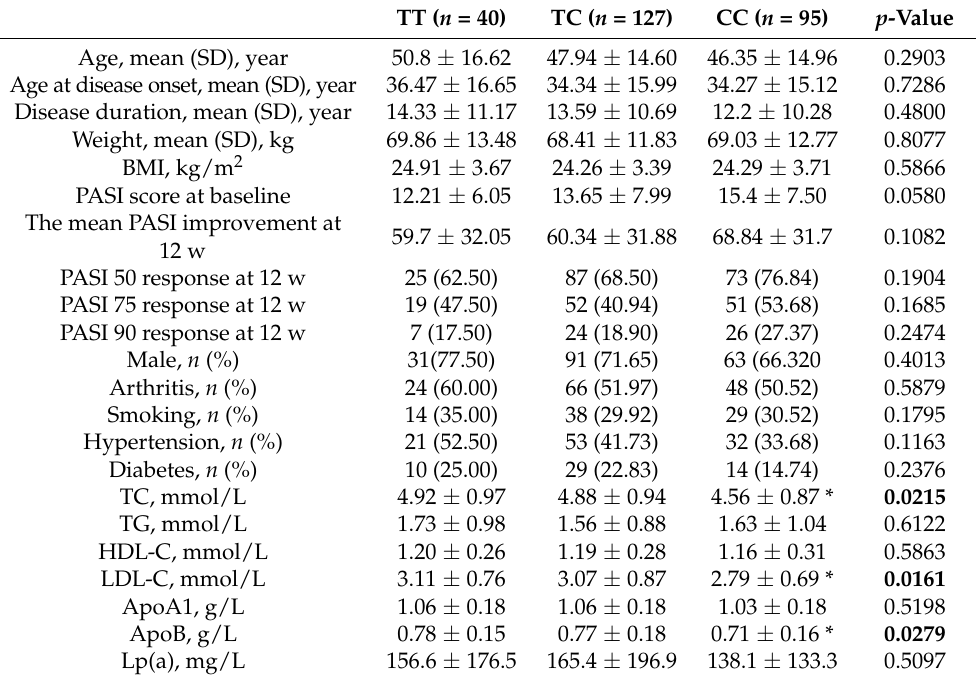
Table 1. Clinical characteristic and the lipid levels according to the rs11960458 genotype of AnxA6 in 262 psoriatic